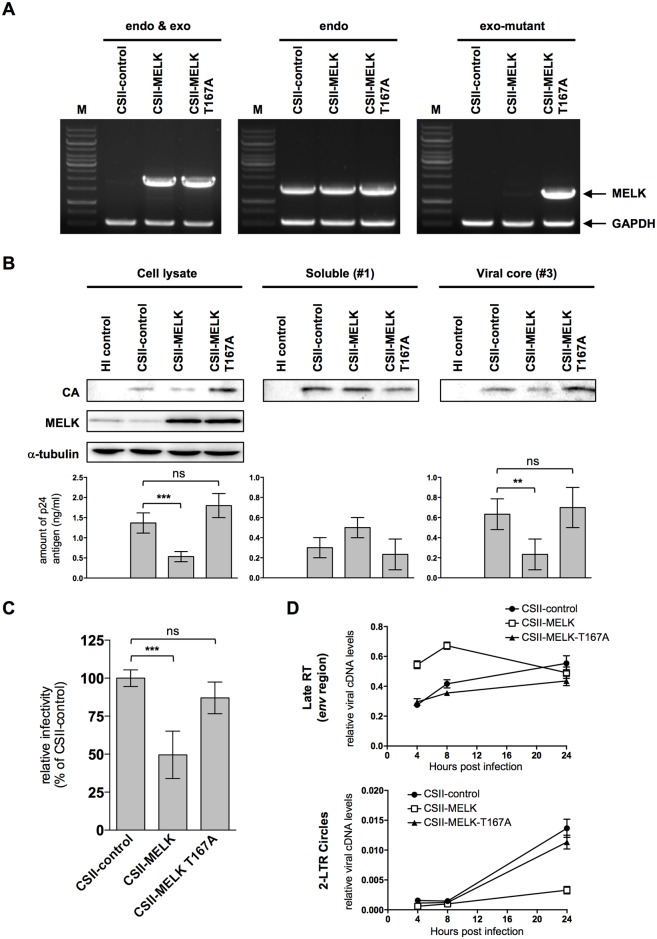
Forced expression of MELK affects the disassembly of HIV-1 core and infectivity.(A) Semi-quantitative RT-PCR analyses of MELK mRNA expression. Total RNA was prepared from Non-T MT4C5 cells transduced with empty lentivirus vector (CSII-control), MELK expression vector (CSII-MELK) or MELK mutant expression vector (CSII-MELK T167A). Total MELK mRNAs (left panel), endogenous MELK mRNA (middle panel) and exogenous mutant MELK mRNA (right panel) were quantitated by RT-PCR amplification with specific primer sets (MELK). A primer set for amplification of GAPDH mRNA was included in each reaction as an internal control (GAPDH). Experiments were performed three times and one set of representative data is shown. (B) Fate-of-capsid assays. Non-T MT4C5 cells transduced with empty lentivirus vector (CSII-control), MELK expression vector (CSII-MELK) or MELK mutant expression vector (CSII-MELK T167A) were infected with NL4-3 for 8 h. HIV-1 stock inactivated by incubation at 65°C for 30 min was used as a negative control (HI control). Cell lysates were prepared and analyzed as in Fig 2I. Aliquots of input, soluble fraction #1 and viral core fraction #3 were processed for immunoblotting with anti-p24 antibody (CA). Input cell lysates were also analyzed by immunoblotting with anti-MELK (MELK) and anti-alpha-tubulin antibodies (α-tubulin). Experiments were performed five times and one representative set of data is shown. The amount of CA in each fraction was quantified by HIV-1 p24 ELISA (lower panels). Error bars indicate the standard deviations calculated from five independent experiments. (C) Non-T MT4C5 cells transduced with empty lentivirus vector (CSII-control), MELK expression vector (CSII-MELK) or MELK mutant expression vector (CSII-MELK T167A) were infected with VSV-G-env-pseudotyped NL4-3luc. Relative luciferase activities are shown as ratios (%) of the RLU of control Non-T MT4C5 cells with standard deviations calculated from five independent experiments. (D) Quantitative DNA-PCR analyses of viral cDNA metabolism after HIV-1 infection of MT4C5 cells. Total DNA was extracted from the indicated cells and analyzed for the amounts of late RT product (upper panel) and 2-LTR circle form (lower panel) as in Figs 1E and 4C. Experiments were performed at least three times and error bars are standard deviations calculated from three independent experiments. The ratios of each viral cDNA level to beta-globin DNA level are given. Statistical significance was determined by one-way analysis of variance (ANOVA) with Dunnett’s multiple comparison test (B and C). ns, not significant (P>0.05); *P<0.05, **P<0.01, ***P<0.001.